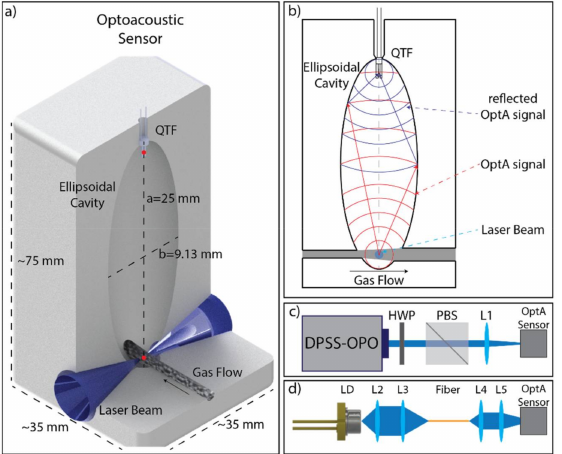
Figure 1. Prototype sensor and experimental setup used in the study. ( a ) Three-dimensional (3D) render of the acoustic chamber configuration across the light path cross-section and its dimension; ( b ) A 2D cross-section along the gas flow that shows the generation, reflection, and refocusing of the optoacoustic sound wave on the quartz tuning fork; ( c – d ) Configuration of the laser excitation systems used; ( c ) the DPSS-OPO laser setup; ( d ) the LD excitation system; DPSS-OPO: Diode Pumped Solid State-Optical Parametric Oscillator, HWP: Half-Wave Plate, PBS: Polarizing Beam Splitter; LD: Laser Diode; L1–L5: Lens